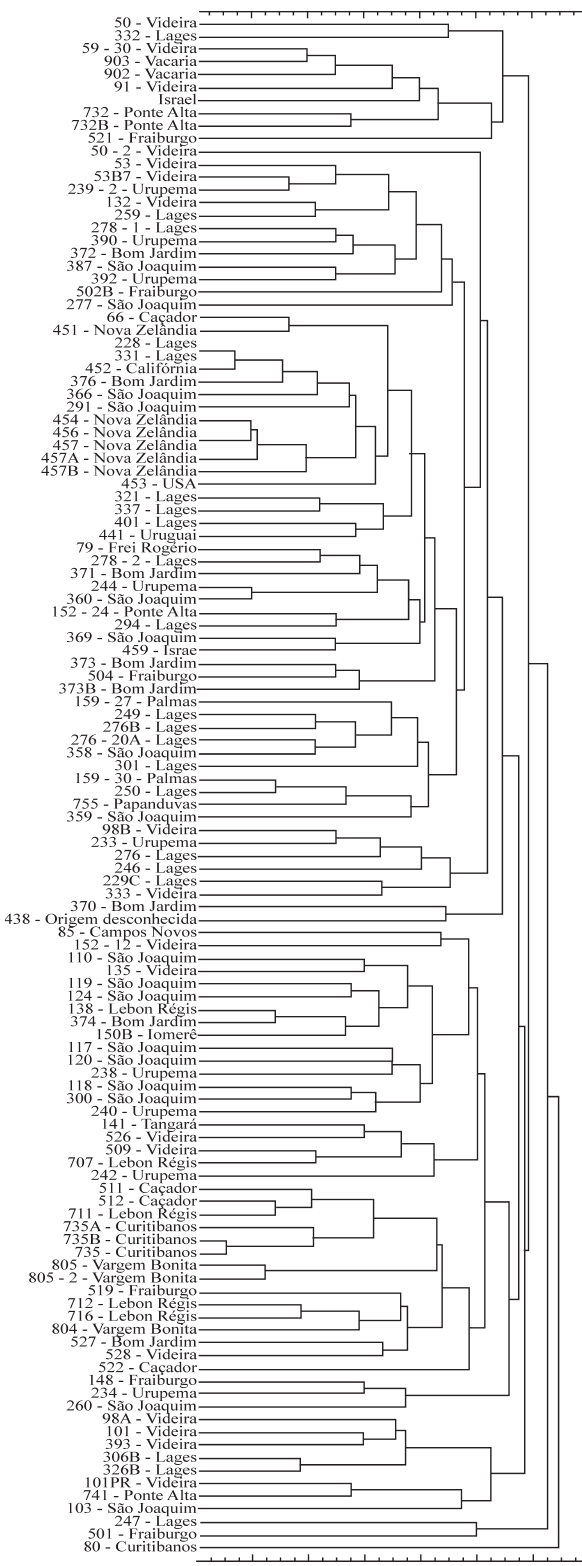
Figure 2 - Unweighted pair group method with arithmetic mean (UPGMA) dendrogram reflecting the genetic similarities, based on 10 microsatellite loci, among 119 accessions from the Acca sellowiana Ac- tive Germplasm Bank.